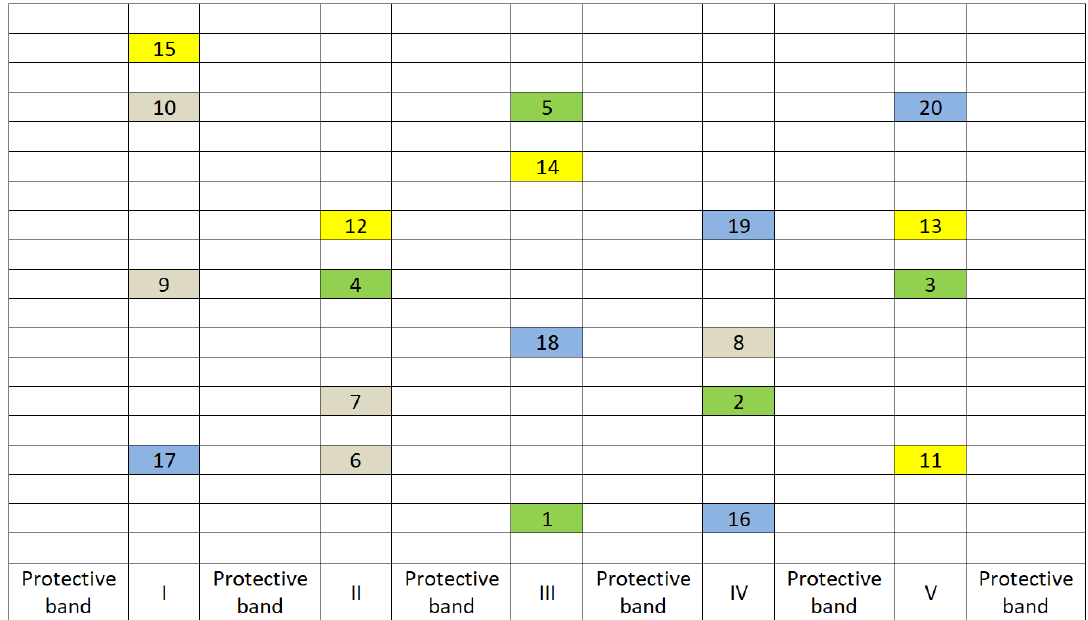
Figure 2. Diagram of the experimental plots’ placement in the field (plots 1–5 control-without weeding, plots 6–10-band spraying, plots 11–15-conventional spraying, plots 16–20-manual weeding. The transverse distance between plots was a minimum of 1.5 m (field patch width). The longitudinal distance within the band (field patch) was a minimum of 10 m. The protective band was 1.5 m (field patch width).